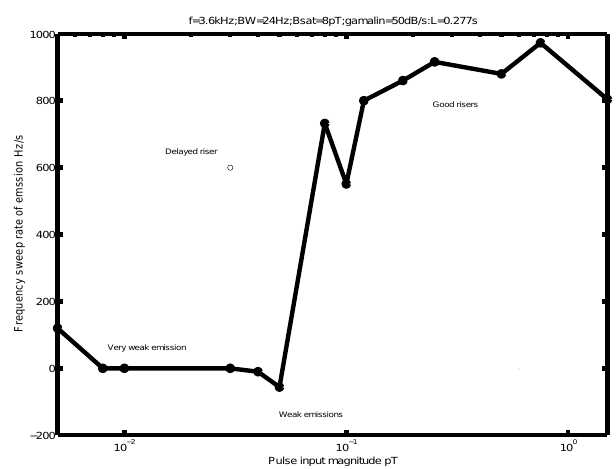
Fig. 15. Dependence of the sweep rate on the input pulse magnitude for a linear growth rate of 50dB/s, which is weaker than for the base case. Now the amplitude threshold is more pronounced, and below about 0.08pT strong triggering does not occur because nonlinear amplitudes are not attained by the time that the pulse reaches the equator.